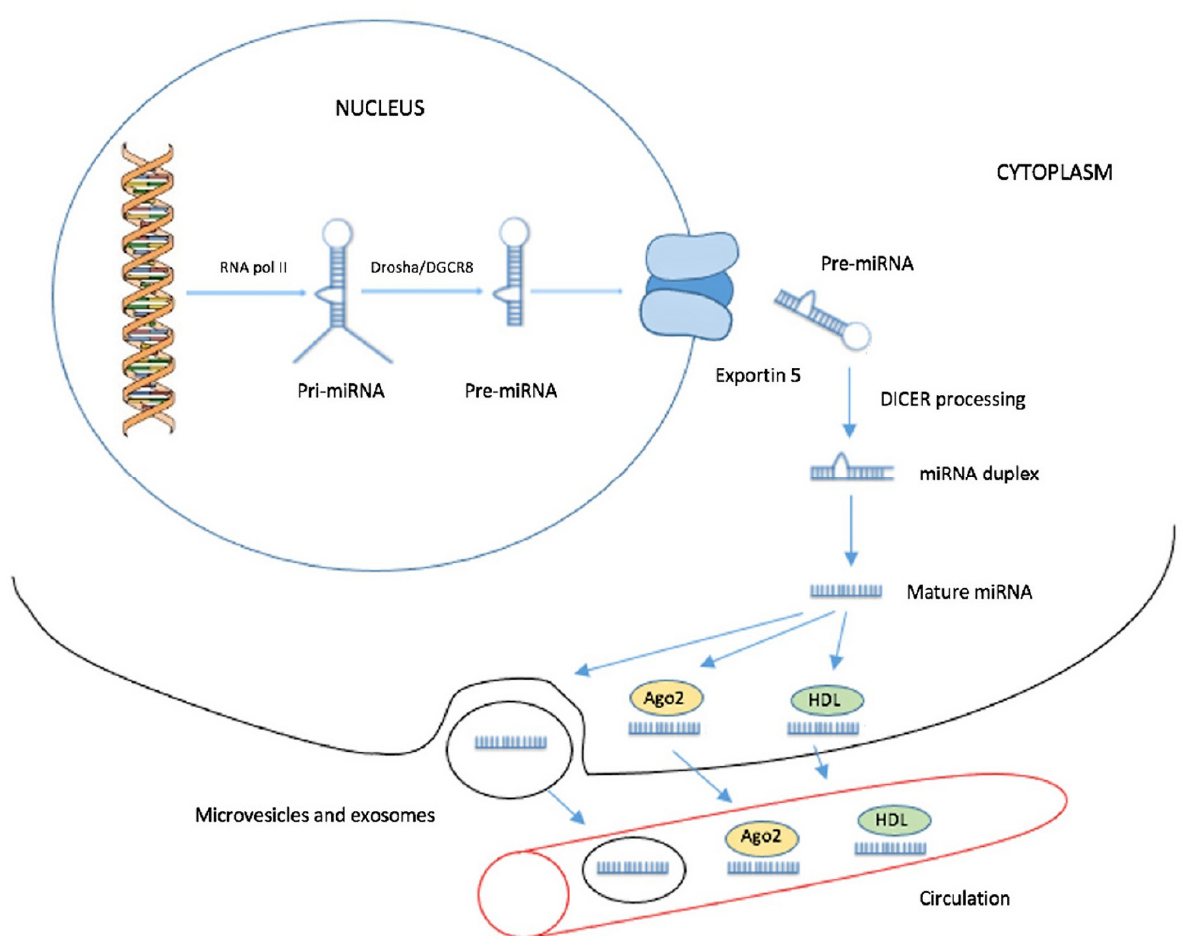
Figure 1. The biogenesis of miRNA is carried out in multiple steps. The miRNA gene is transcribed to generate a primary miRNA (pri-miRNA). After the cleavage of the pri-miRNA to a precursor miRNA (pre-miRNA), the pre-miRNA is exported from the nucleus to the cytoplasm. Last, the pre-miRNA is cleaved to a miRNA duplex, a strand of which is loaded on RISC. There are three mechanisms of miRNA releasing into the circulation: (1) secretion within exosomes, (2) secretion within a complex with the Ago2 protein, and (3) secretion within a complex with HDL.